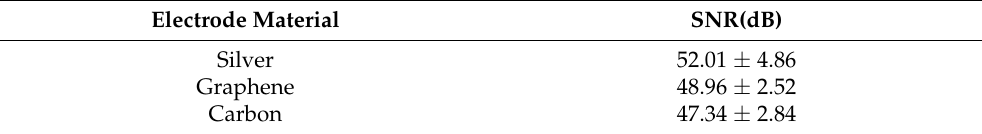
Table 2. Signal to Noise